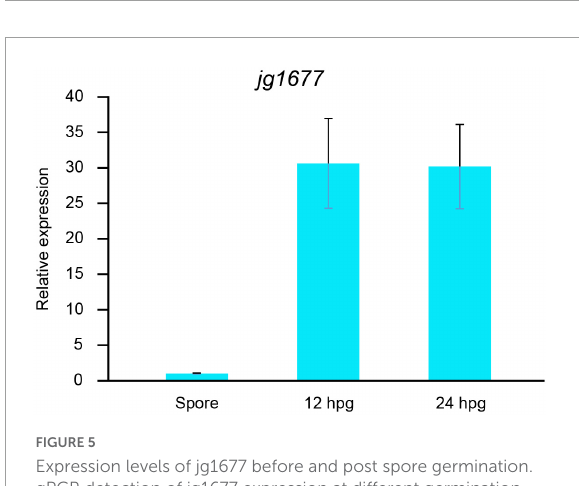
FIGURE4 Expression of jg1677 at different temperatures. qPCR detection of jg1677 expression at different temperatures. Data are shown as the expression of jg1677 compared to that at 25 ◦ C. Error bars represent SD.